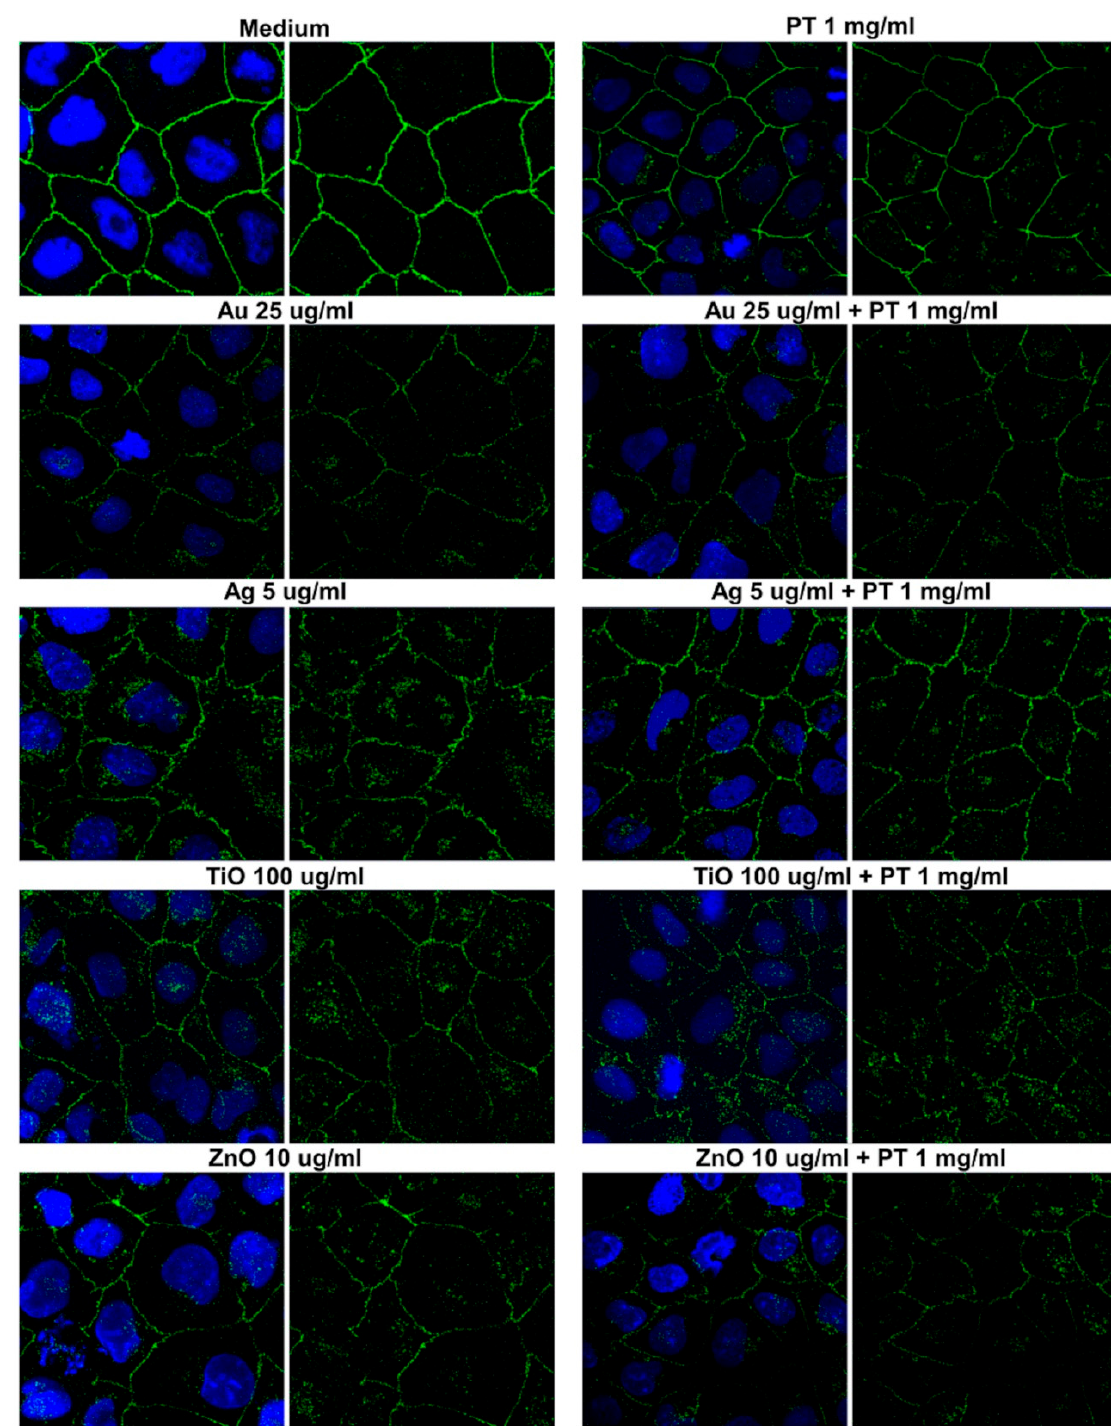
Figure 7. Occludin immunofluorescence in post-confluent Caco2 cells. Left panels show the overlay with DAPI, and right panels show the OCLN signal alone (63× magnification).